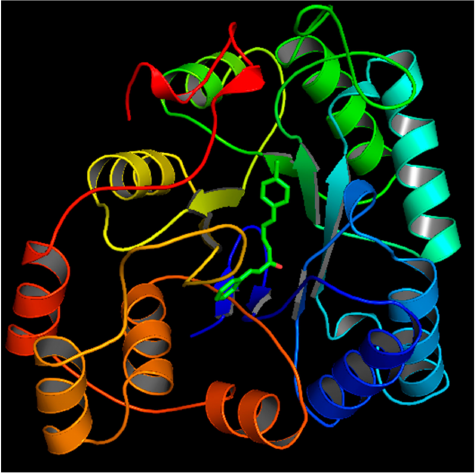
Figure 3. Docking view of curcuminoid 10g (molecular weight = 294.77) (green sticks) in the binding site of AR. The protein structures are shown in ribbon representation.